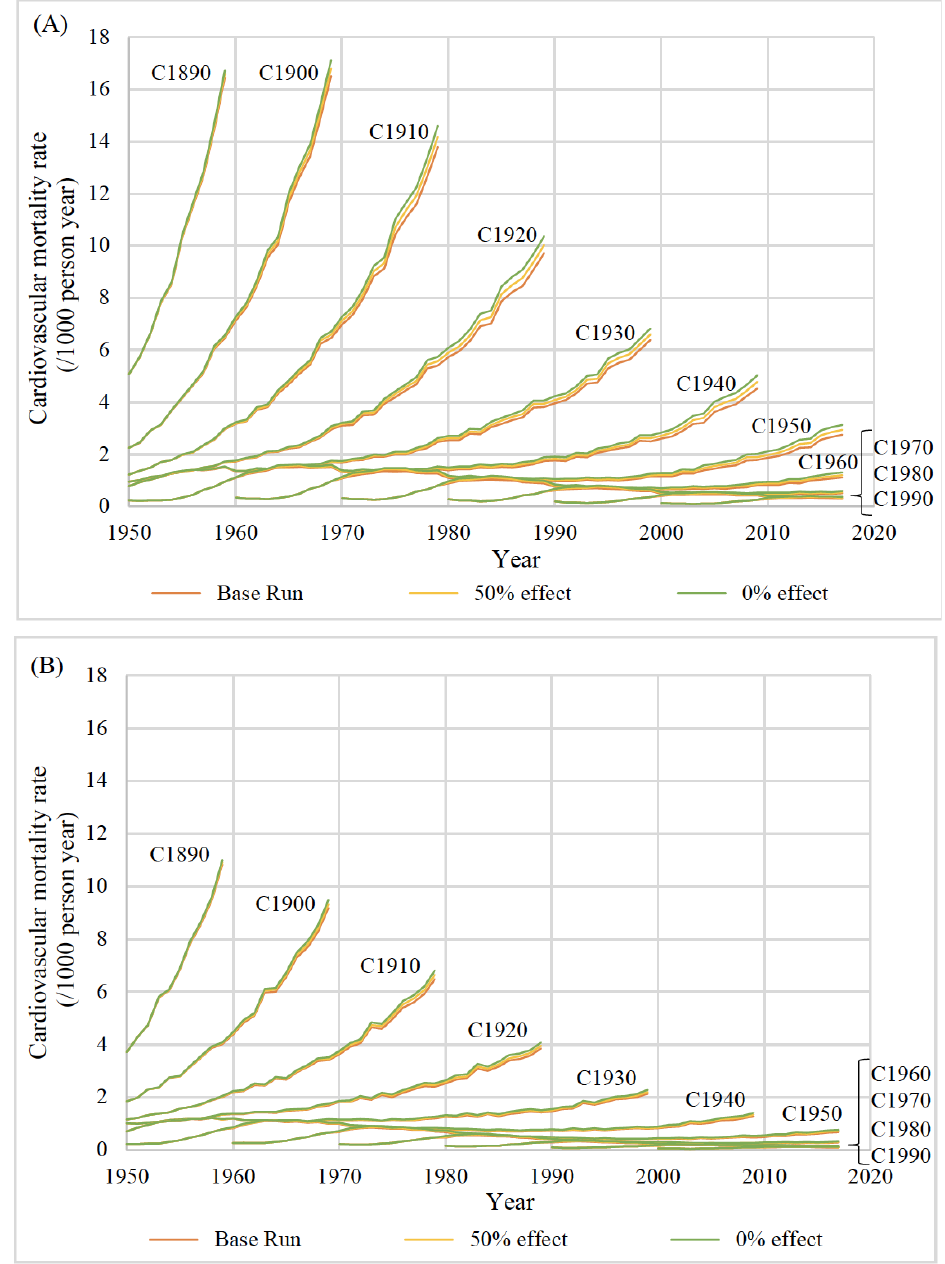
Figure 3. Estimated cardiovascular mortality rates in selected birth cohorts in men ( A ) and women ( B ). The numbers following the letter “C” indicate birth years (e.g., C1890 represents the 1890 birth cohort). Base run: the actual effect of salt-intake reduction on the cardiovascular mortality rate; 50% effect: 50% of the actual effect of salt-intake reduction; 0% effect: no effect of salt-intake reduction since 1950.